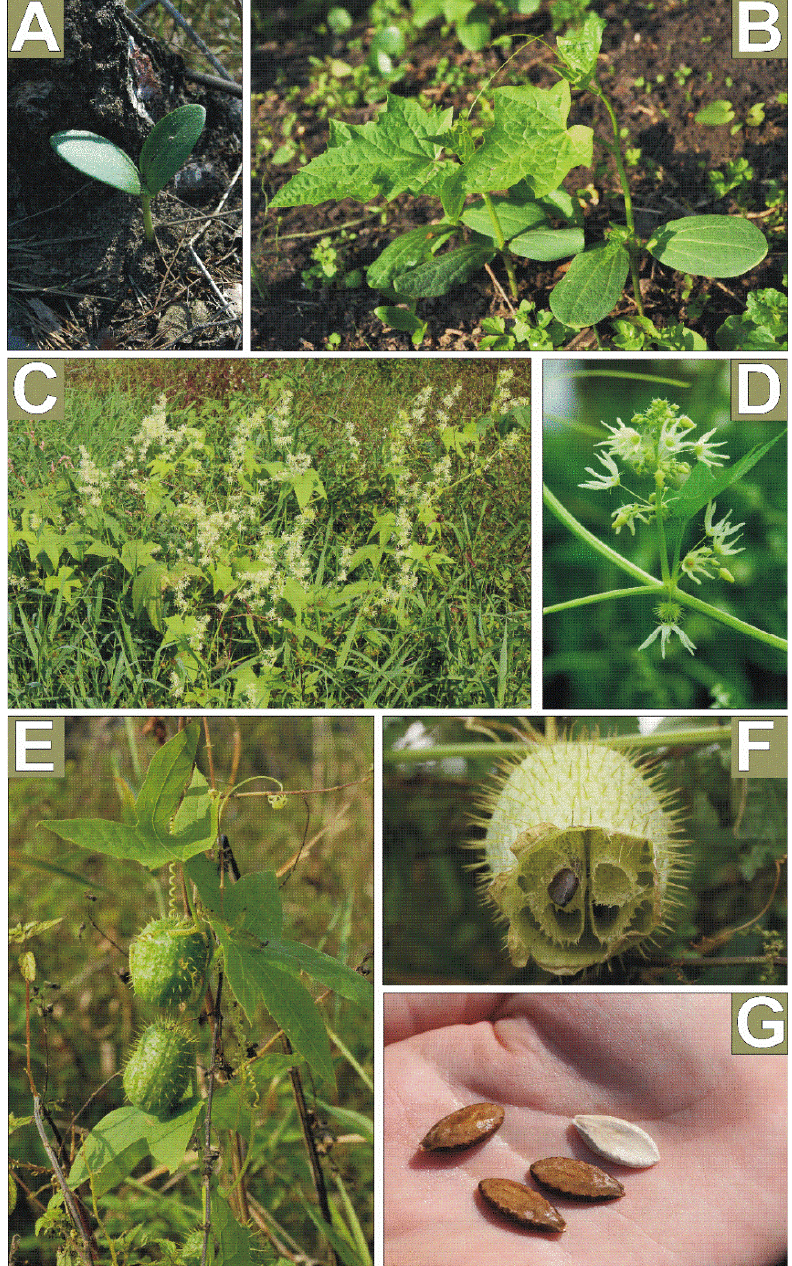
Figure 1. Morphological characteristics of Echinocystis lobata : ( A )—seedling, ( B )—young specimens with first leaves and tendrils, ( C )—mature individual in a typical waterside habitat, ( D )—fragment of the shoot with flowers, ( E )—fruits (pepos), ( F )—pen fruit at the stage of seed release, ( G )—seeds (photographed by Z.